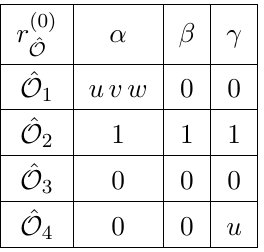
Table 2 . Normalized tree-level form factors r (0)